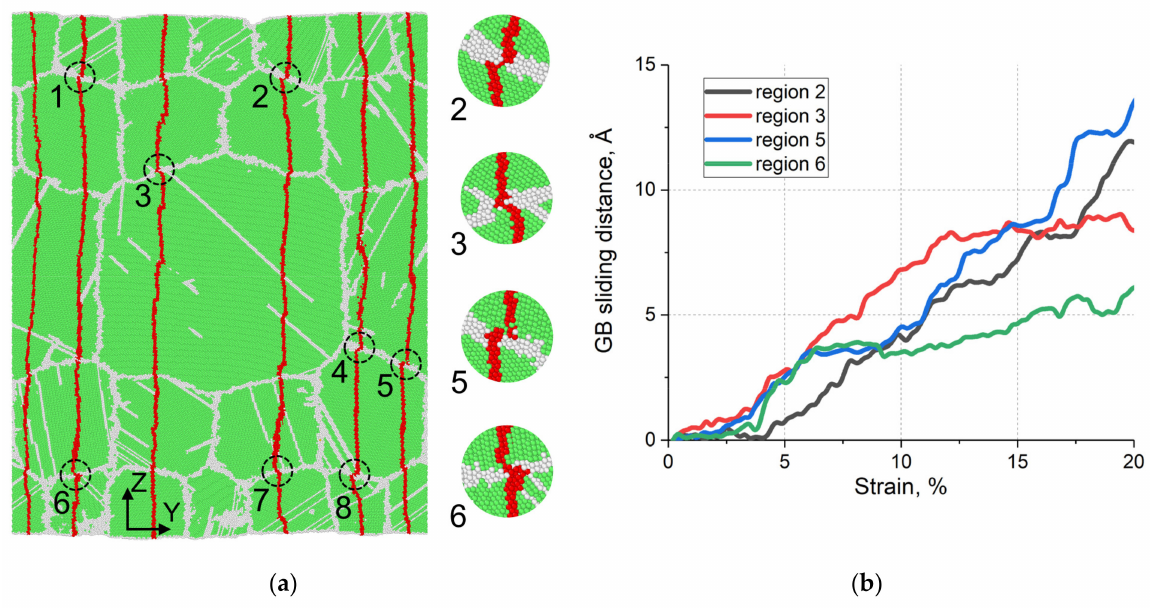
Figure 8. ( a ) Sample cross section at X = 40 nm for strain 15.0% showing the result of GB sliding. Atoms with fcc nearest neighbor symmetry are highlighted in green. Atoms located on straight lines at 0% strain are red. Atoms belonging to GBs and structural defects are light gray. ( b ) GB sliding distance vs. strain in the regions circled in Figure ( a